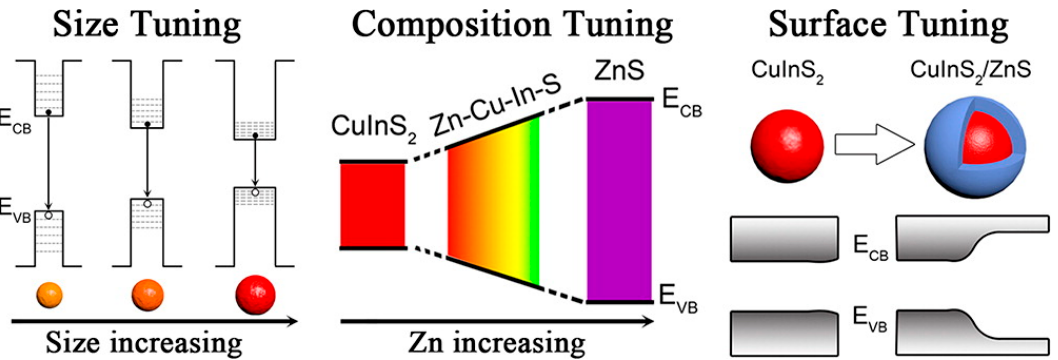
Figure 1. The strategies (size tuning, composition tuning, and surface tuning) that are applied to synthesize the highly luminescent CuInS 2 NCs [26].